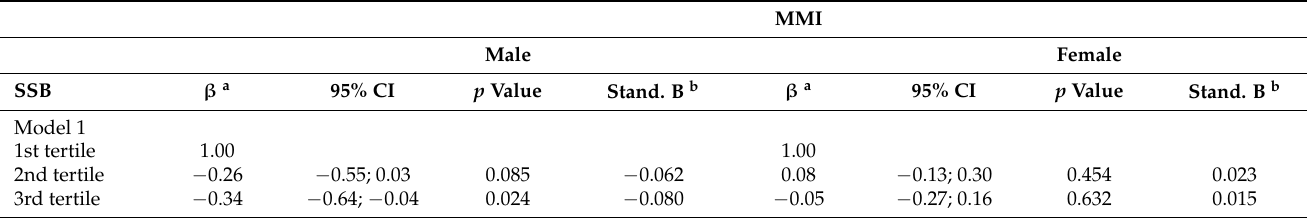
Table 4. Association between the energy contribution of sugar-sweetened beverages and muscle mass index in adolescents according to sex. Sao Luis, MA,